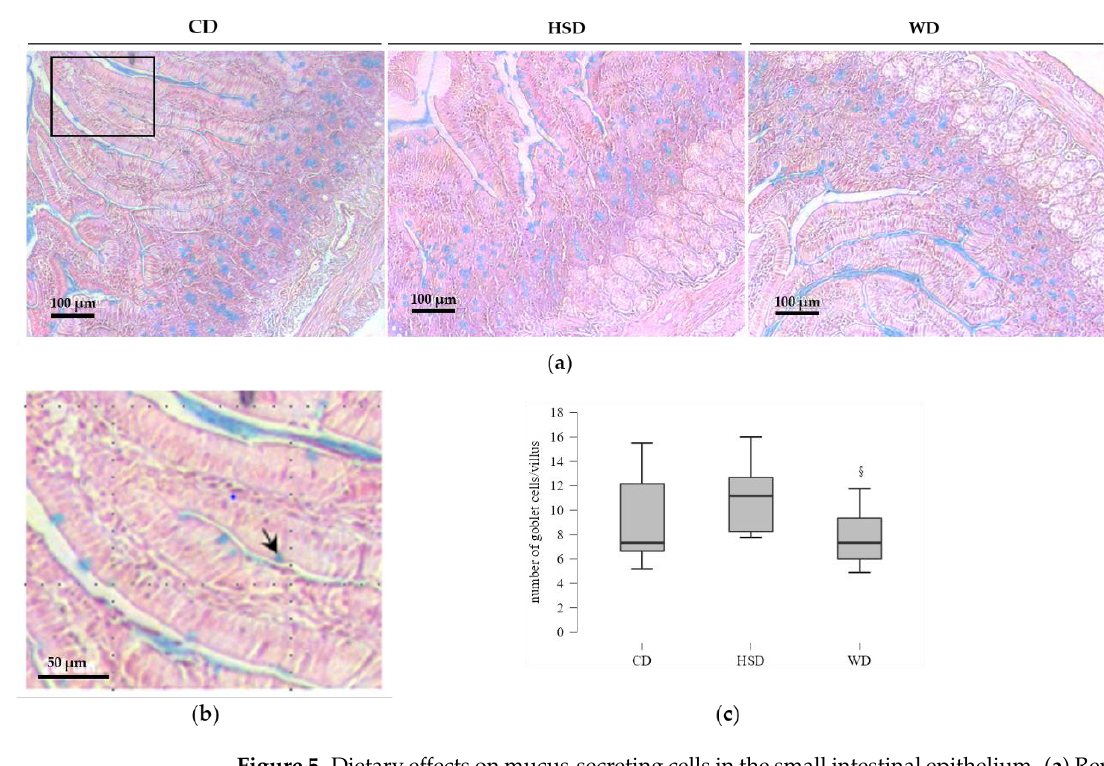
Figure 5. Dietary effects on mucus-secreting cells in the small intestinal epithelium. ( a ) Representative images of Alcian blue staining of transversal sections of duodenum from chow diet (CD), high-sugar diet (HSD), and Western diet (WD) groups. ( b ). Inset of the box showing blue stained goblet cells, which is indicated by an arrow. ( c ) Number of goblet cells per villus of duodenum ( n = 5 – 8 villi per rat). Symbol indicates significant differences (one-way ANOVA) compared to HSD-fed group: § p < 0.05.